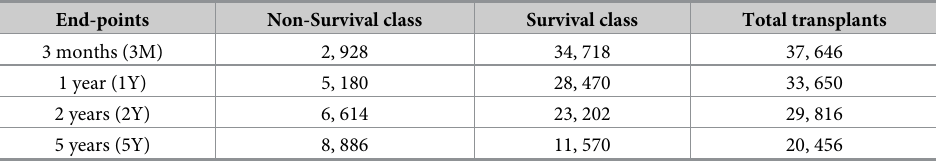
Table 1. Number of transplants performed for each end-point and their class